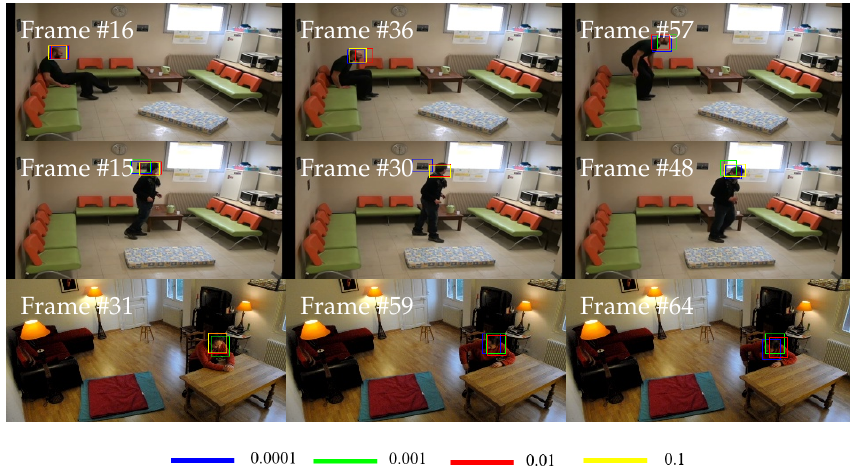
Figure 13. Some image samples of B output for all learning rates, showing F fail in the beginning of